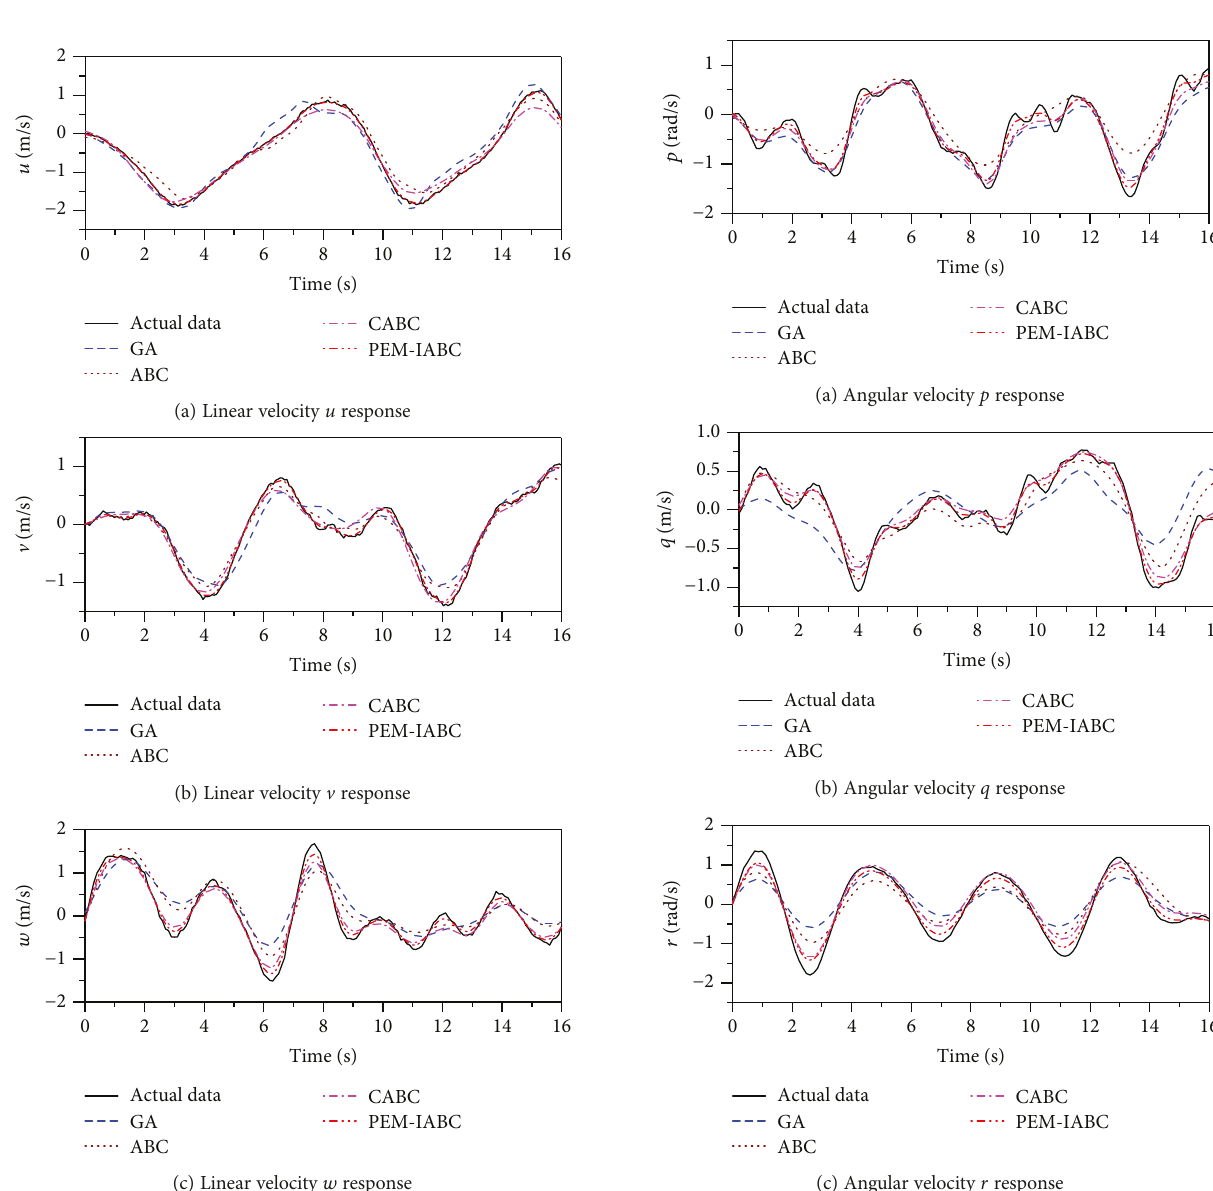
Figure 6: Responses of the attitudes.